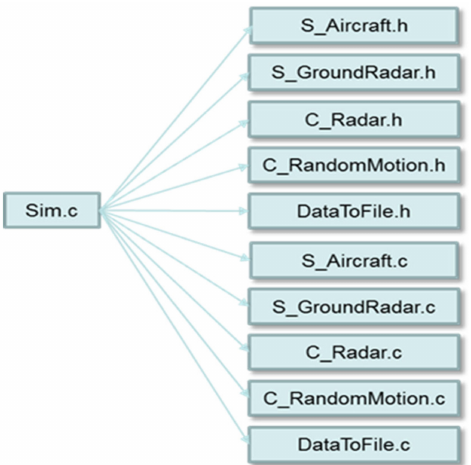
Figure 10. Di ff erent methods in the C programming language adapted to WarpIV to program the case study of Figure